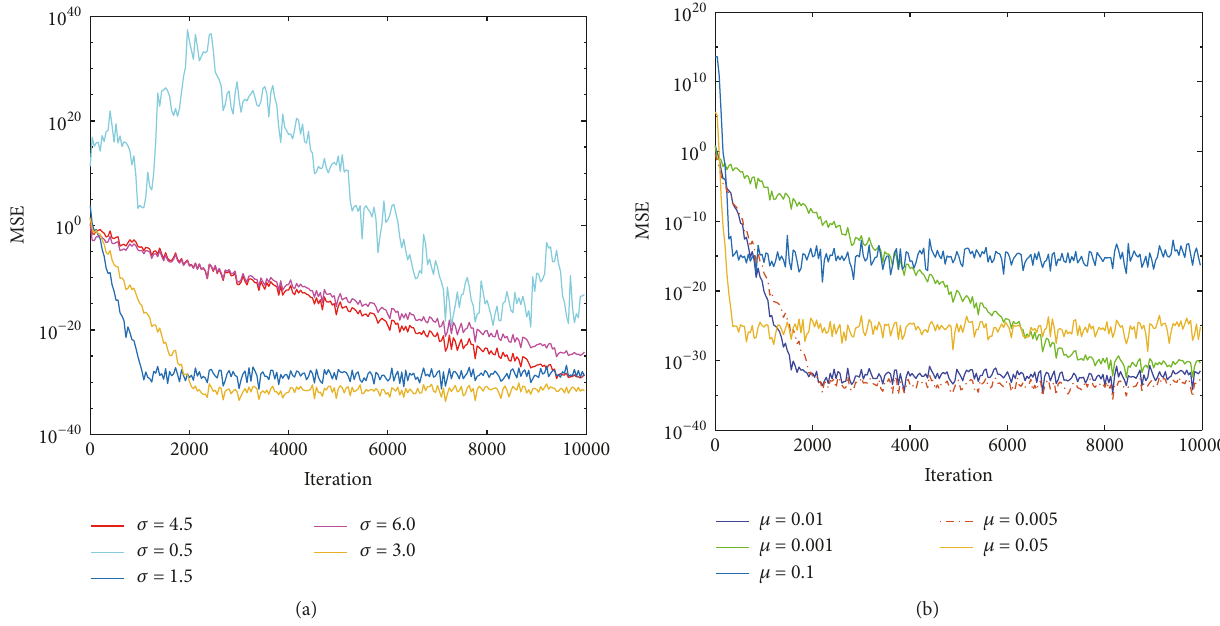
Figure 8: MSE learning curves of the proposed CSMC with different used parameters: (a) MSE for different kernel size; (b) MSE for different step parameter.